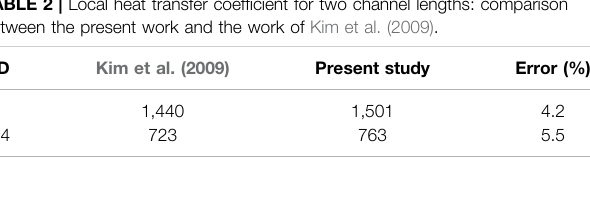
TABLE 3 | Comparison of the result between the S-P and T-P models with the experimental data Ho and Chen (2013). Re 135 390 655 1,530 Average Nusselt number Ho and Chen